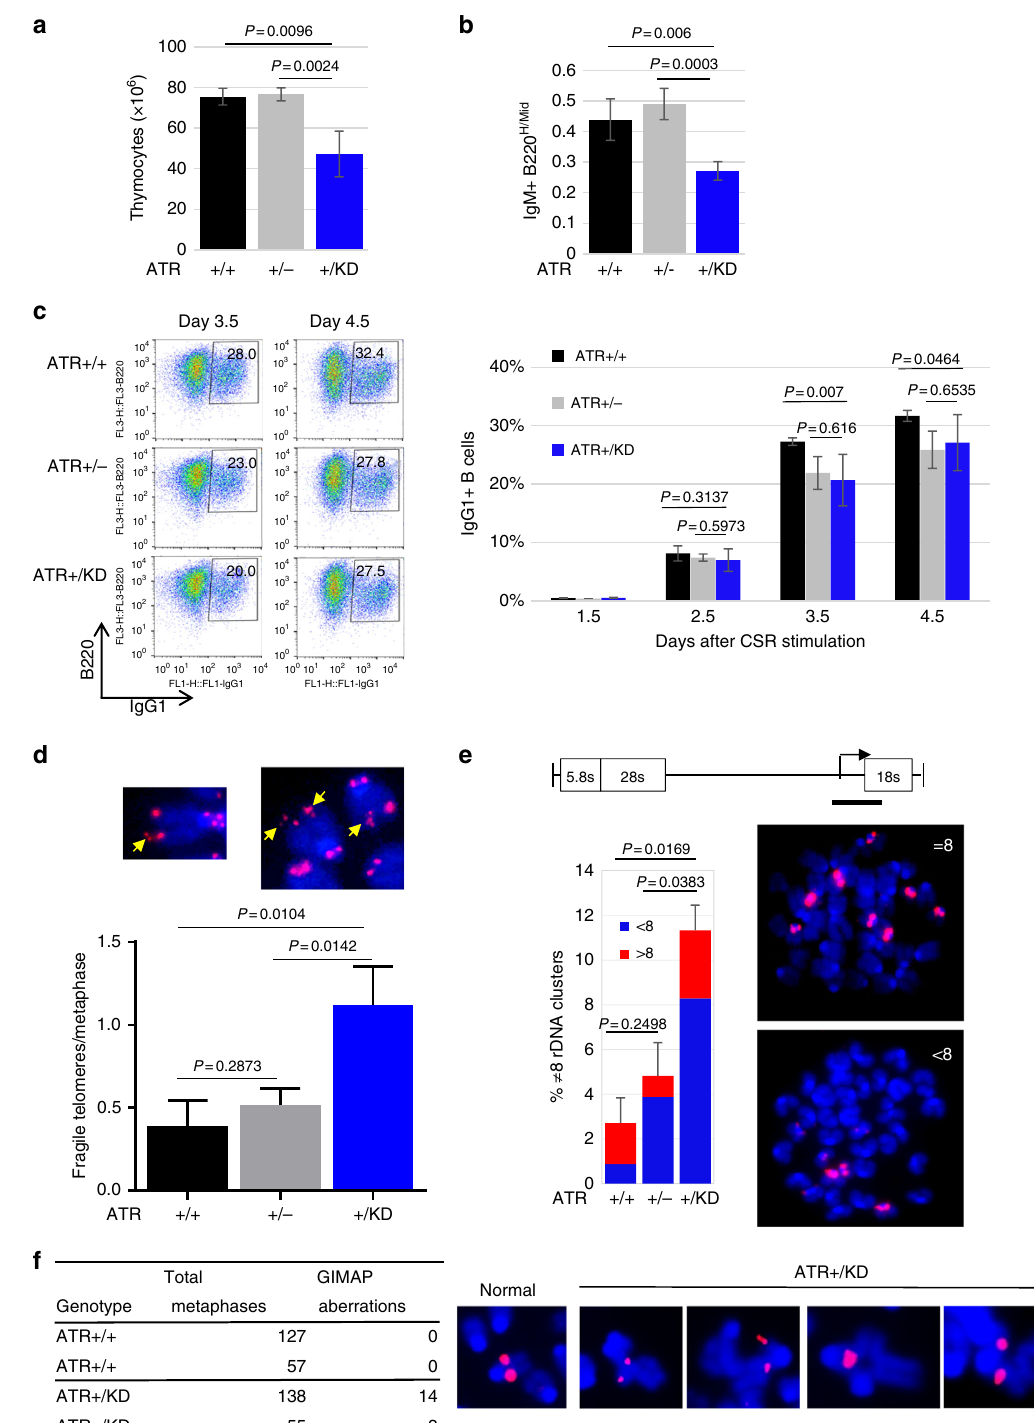
Mild lymphocytopenia in Atr + /KD mice . To ascertain whether ATR-KD has also ssDNA-dependent dominant-negative effects during mitosis, we analyzed lymphocyte development. Thymus cellularity and thymus net weight decreased nearly ~50% in Atr + /KD mice relative to Atr + / + and Atr + / − mice (Fig. 2a and Supplementary Fig. 3c). Yet, the relative frequency of different blood cell types (e.g., lymphoid, myeloid, or erythroid) or between different developmental stages (i.e., progenitors vs native lym- phocytes) were quite similar among the Atr + /KD , Atr + / − ,